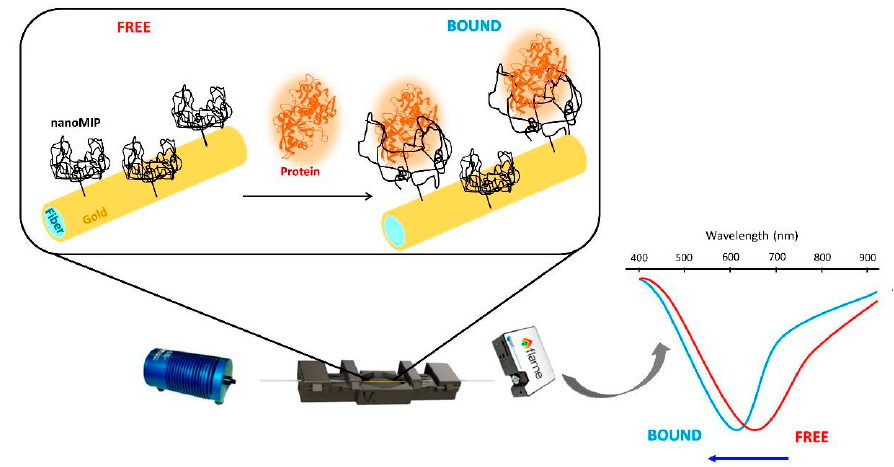
Figure 8. Scheme of the operating principle of the nanoMIPs-based SPR-LFD platform for HTR detection. (Reproduced with permission from [75], open access Creative Common CC licensed 4.0, MDPI).